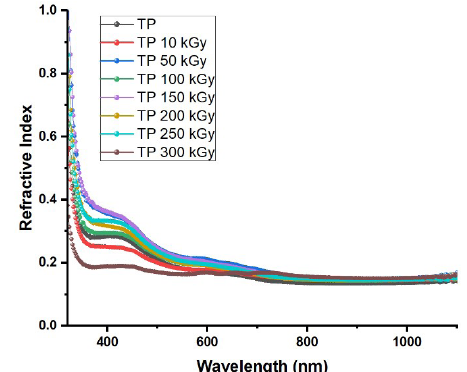
Figure 6. Refractive index of different gamma-absorbed doses of TIPS